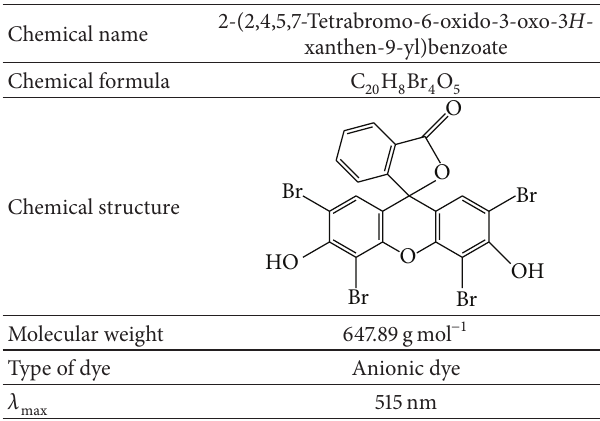
Table 1: The characteristics of eosin Y